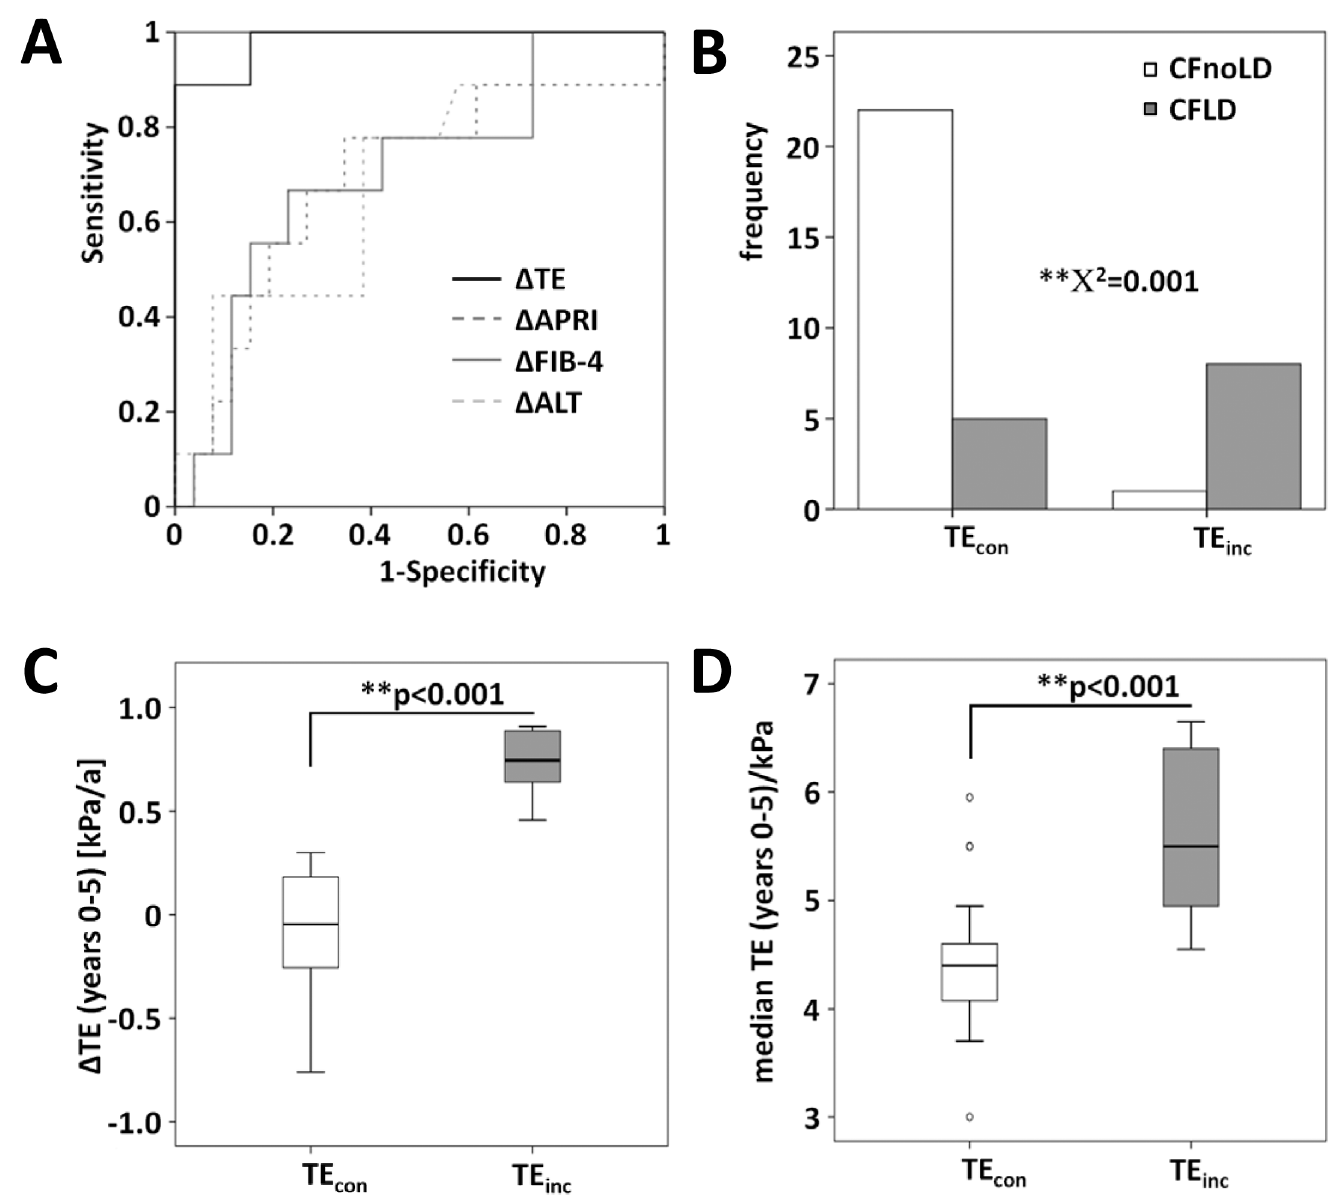
Fig 2. The increasein liver stiffness ( Δ TE) defines the development of CFLD in pediatric patients. (A) The receiveroperatingcharacteristics (ROC) analysisidentifieda consistentincrease of liver stiffness in 9 of 10 pediatricpatients with a TE(4–5) > 6.3 kPa and fixed the cut-off as rationalefor grouping Δ TE cut-off = 0.38 kPa/year. The frequency of CFLD (B) , the enhancement of liver stiffness Δ TE (C) , and the median stiffness (D) was increased in the TE inc -group comparedto the TE con